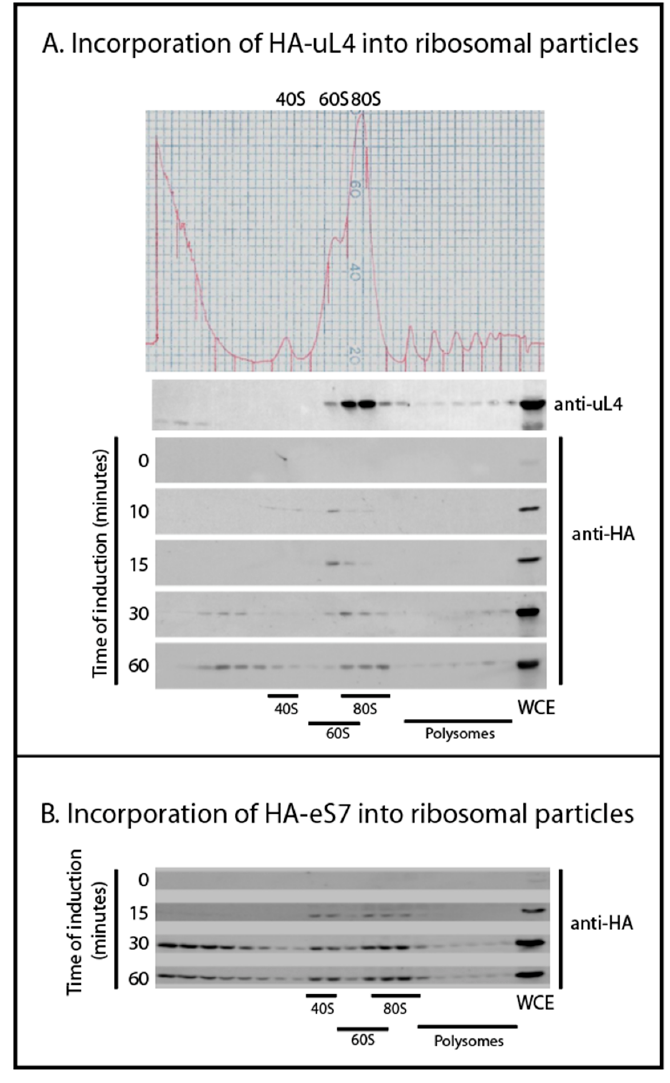
Figure 2. Incorporation of HA-tagged ribosomal proteins into precursor and mature ribosomes. Cells were harvested at different times after inducing the synthesis of HA-uL4 or HA-eS7. Whole cell lysates were fractionated on sucrose gradients and gradient fractions were analyzed on Western blots probed with anti-uL4 or anti-HA. ( A ) Induction of HA-uL4. ( B ) Induction of HA-eS7. Induction times are indicated by each Western blot.